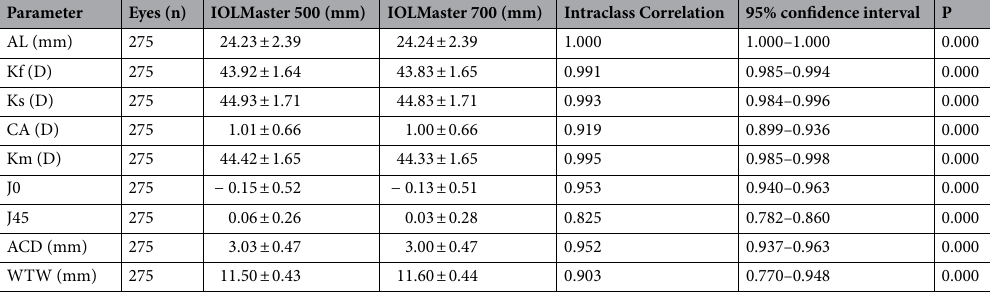
Table 1. The results of biometry measurements by IOL Master 500 and IOL Master 700.